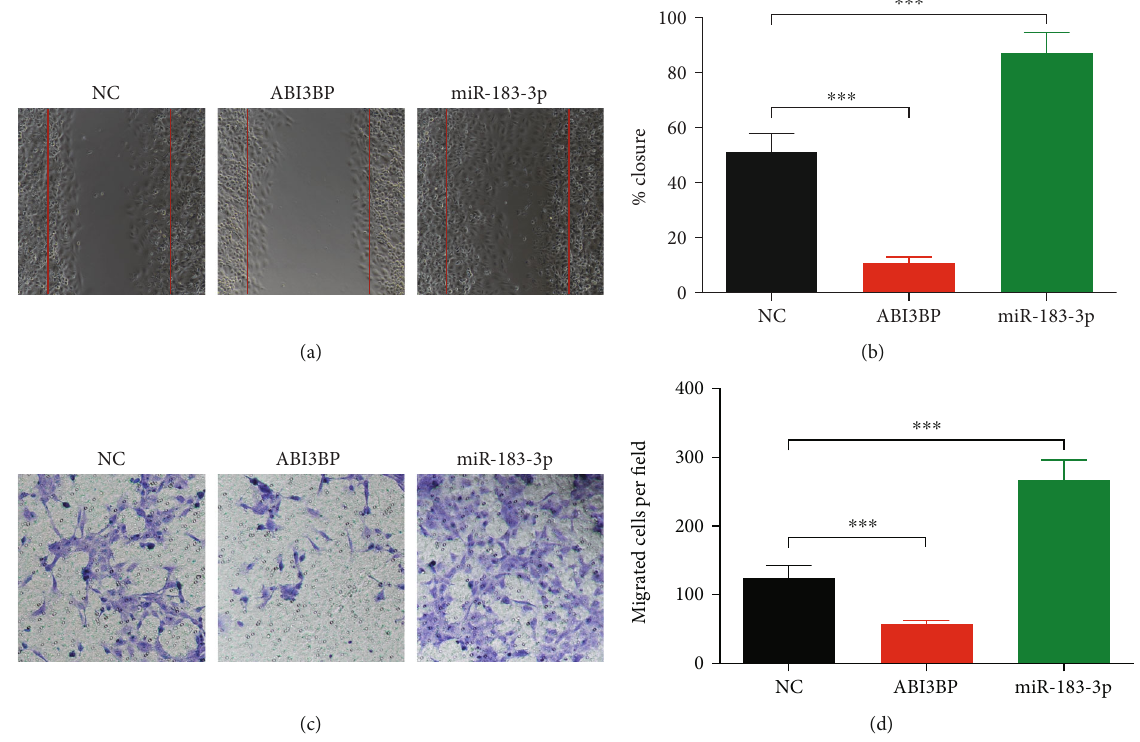
Figure 6: ABI3BP and miR-183 modulate the migration and invasion in EC cells. (a) After being transfected with ABI3BP or miR-183 for 24h, the migration ability of EC cells was assessed by wound healing assay. Five independent experiments ( n = 5 ) were repeated for each group. (b) Quantitative analysis of (a). (c) After being transfected with ABI3BP or miR-183 for 24 h, the invasion ability of EC cells was assessed by Transwell assays. Five independent experiments ( n = 5 ) were repeated for each group. (d) Quantitative analysis of (b). ∗∗∗ P < 0 : 001 , one-way ANOVA with post